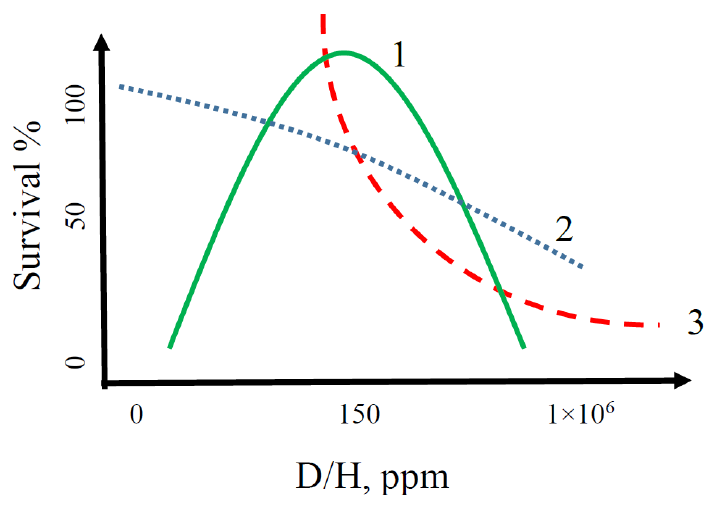
Figure 2. Possible kinetic model diagram of the vital activity of high-level biological taxons depending on the D/H ratio in the aquatic environment (1—animal; 2—bacteria; 3—plants).